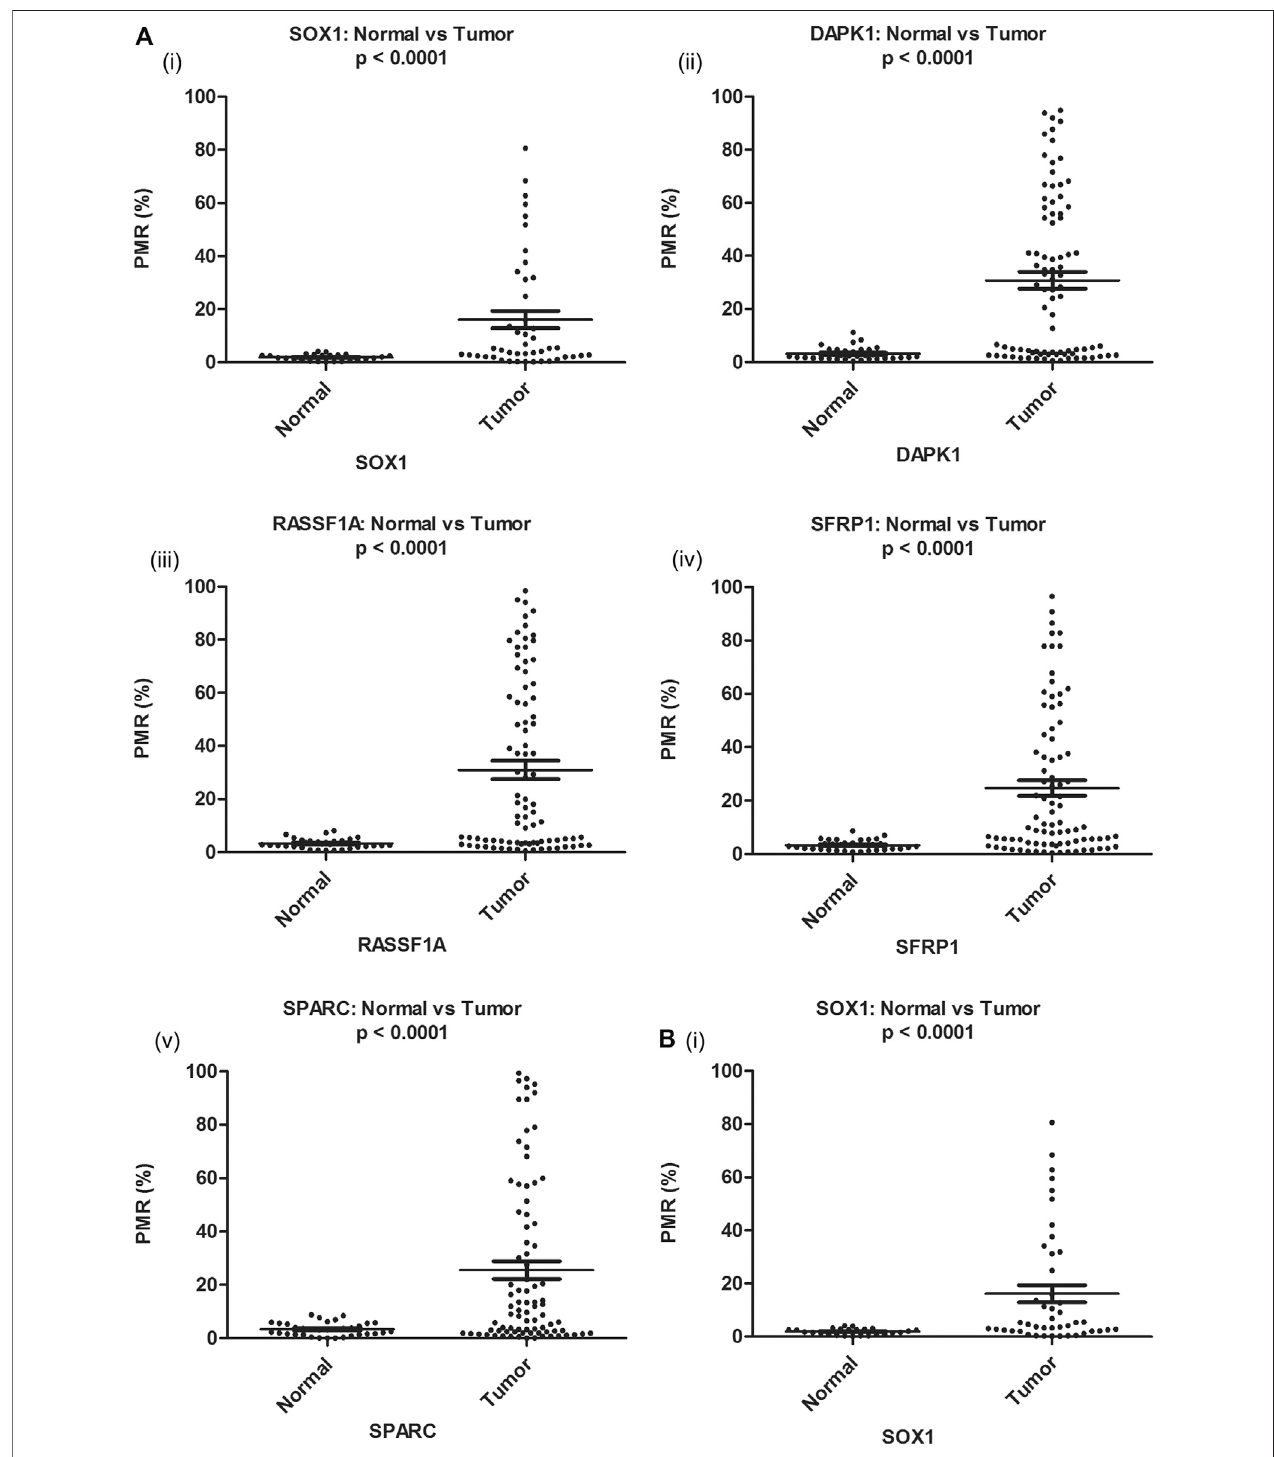
FIGURE 1 | Distribution of PMR value of candidate genes in EOC and corresponding noncancerous normal tissue samples (Ai – v) and serum samples (Bi) respectively.DistributionofPMRvalueofHOXA9andHIC1geneinEOCandcorrespondingnoncancerousnormaltissueandserumsampleshasbeenpublished(Singh et al., 2020). PMR: percentage of methylated